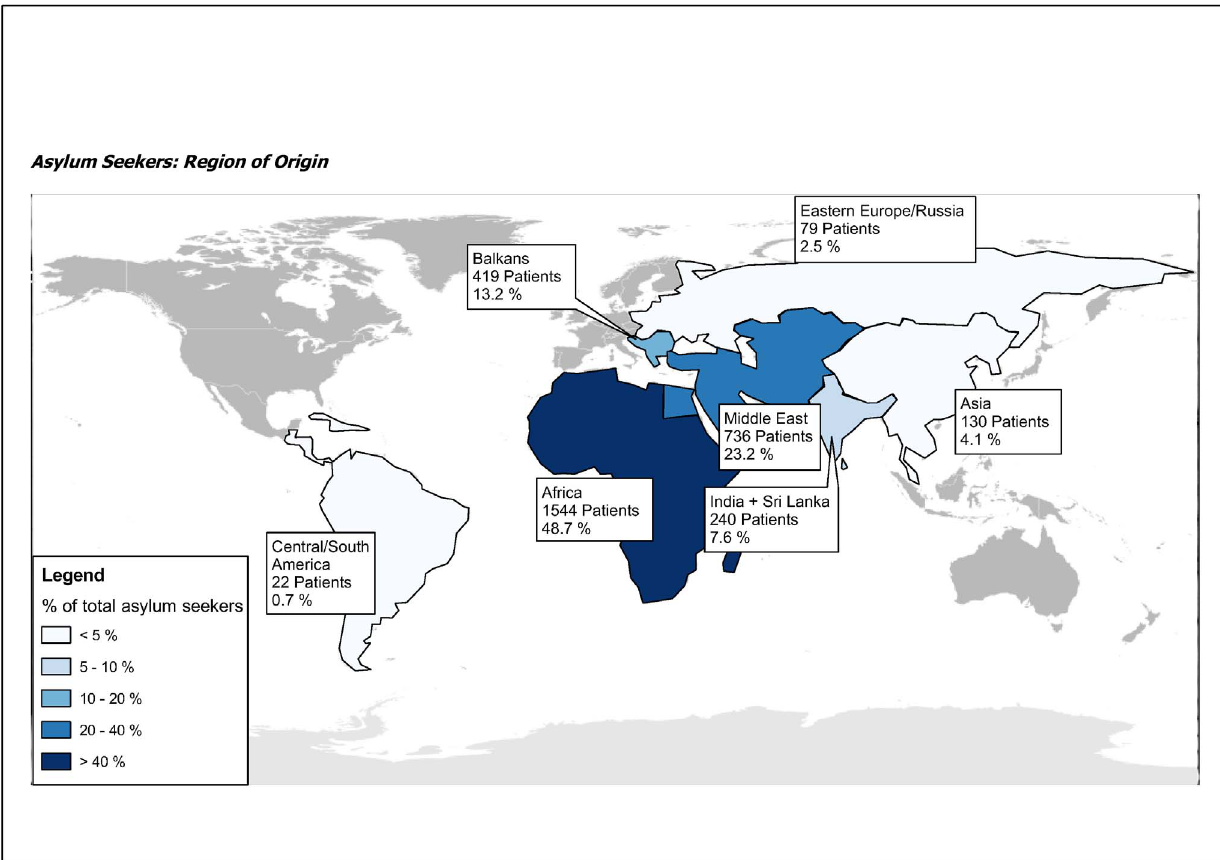
Figure 1. Overview on geographical origin.